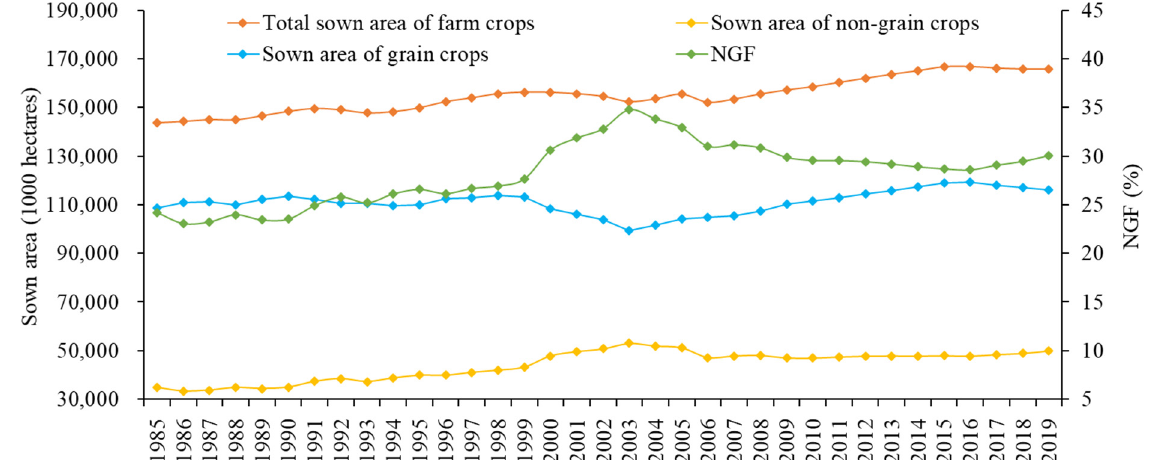
Figure 1. The evolution of NGF and sown areas of farm crops in China from 1985 to 2019.